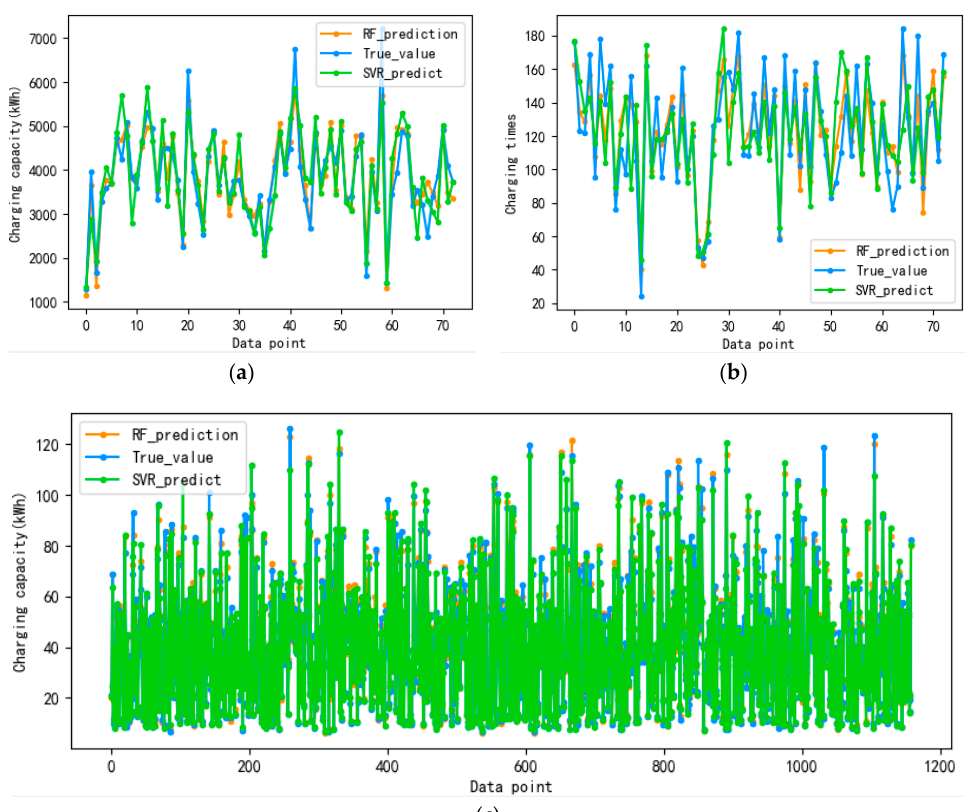
Figure 6. Load forecast curve of single charging station: ( a ) daily charging capacity; ( b ) daily charging times; and ( c ) charging capacity every 15 min.